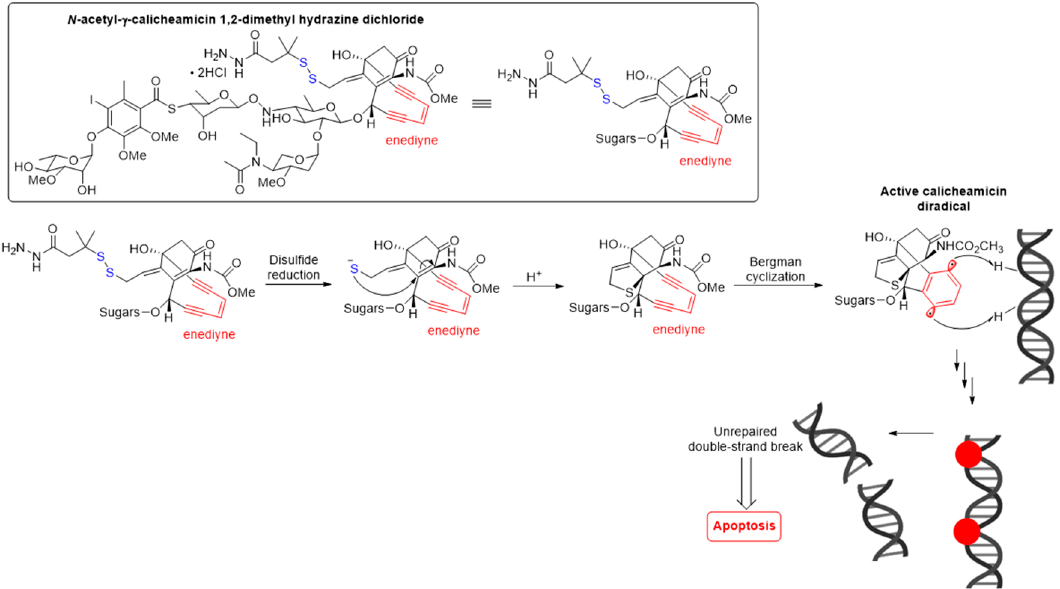
Figure 5. Mechanism for double-strand (ds) DNA cleavage by N -acetyl- γ -calicheamicin. The enediyne warhead is shown in red.